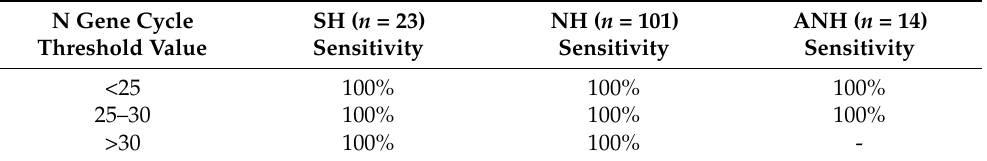
Table 3. The overall sensitivity of the GeneFinder COVID-19 Ag Plus Rapid Test according to the N gene cycle threshold in SH, NH and ANH